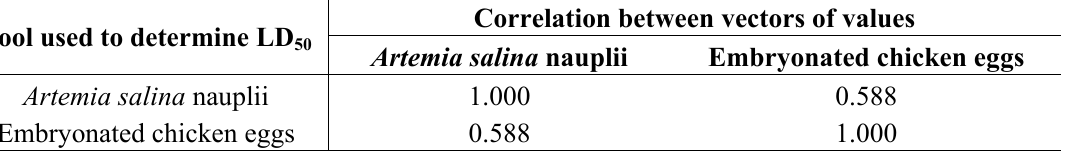
Table 7. Proximity matrix of Artemia salina nauplii and chicken embryos calculated from LD yield of T. indica 50